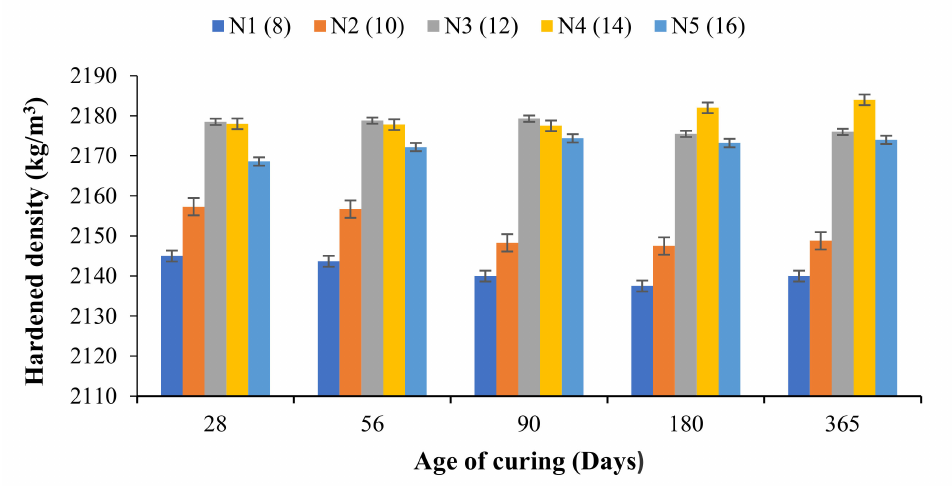
Figure 3. Hardened density of N1–N5